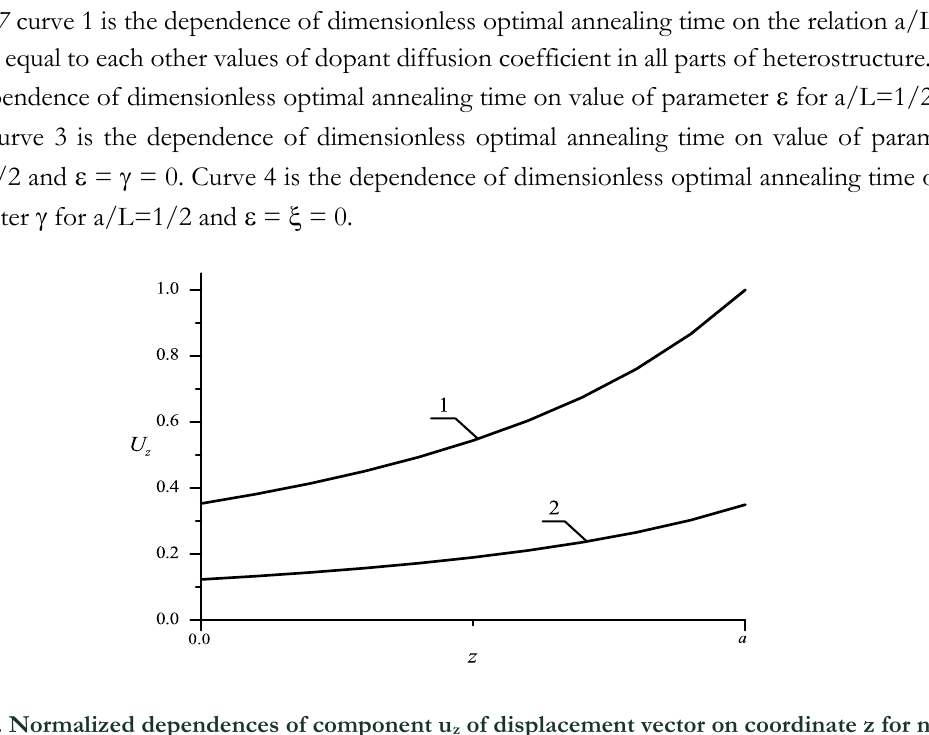
Fig. 8. Normalized dependences of component u z of displacement vector on coordinate z for nonporous (curve 1) and porous (curve 2) epitaxial layers.